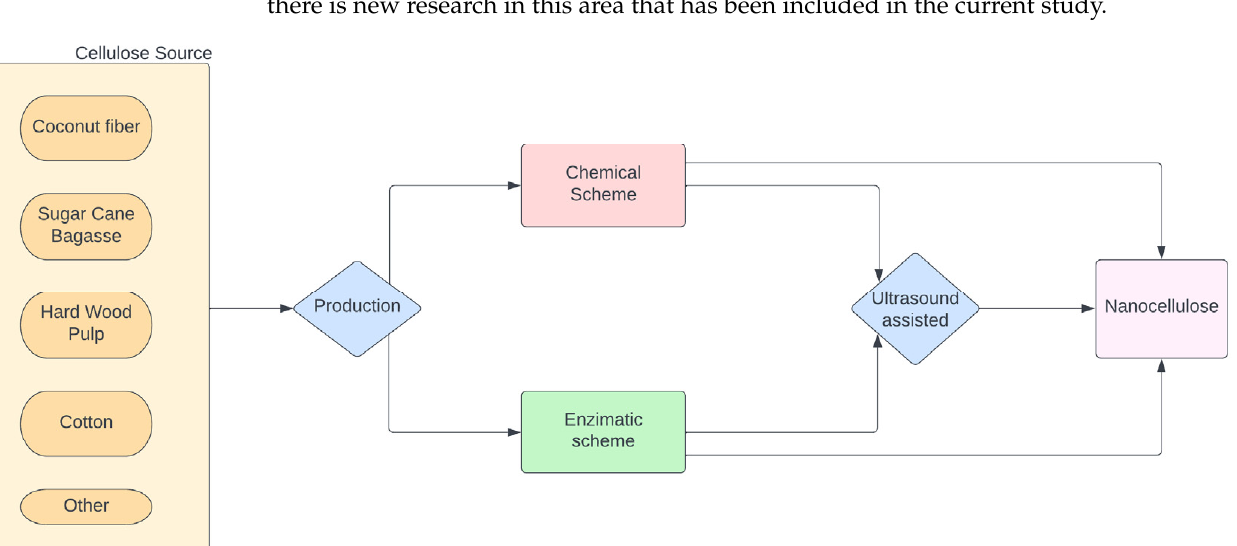
Table 3. Literature review for the Life Cycle Assessment of the production of nanocellulose and its composites.